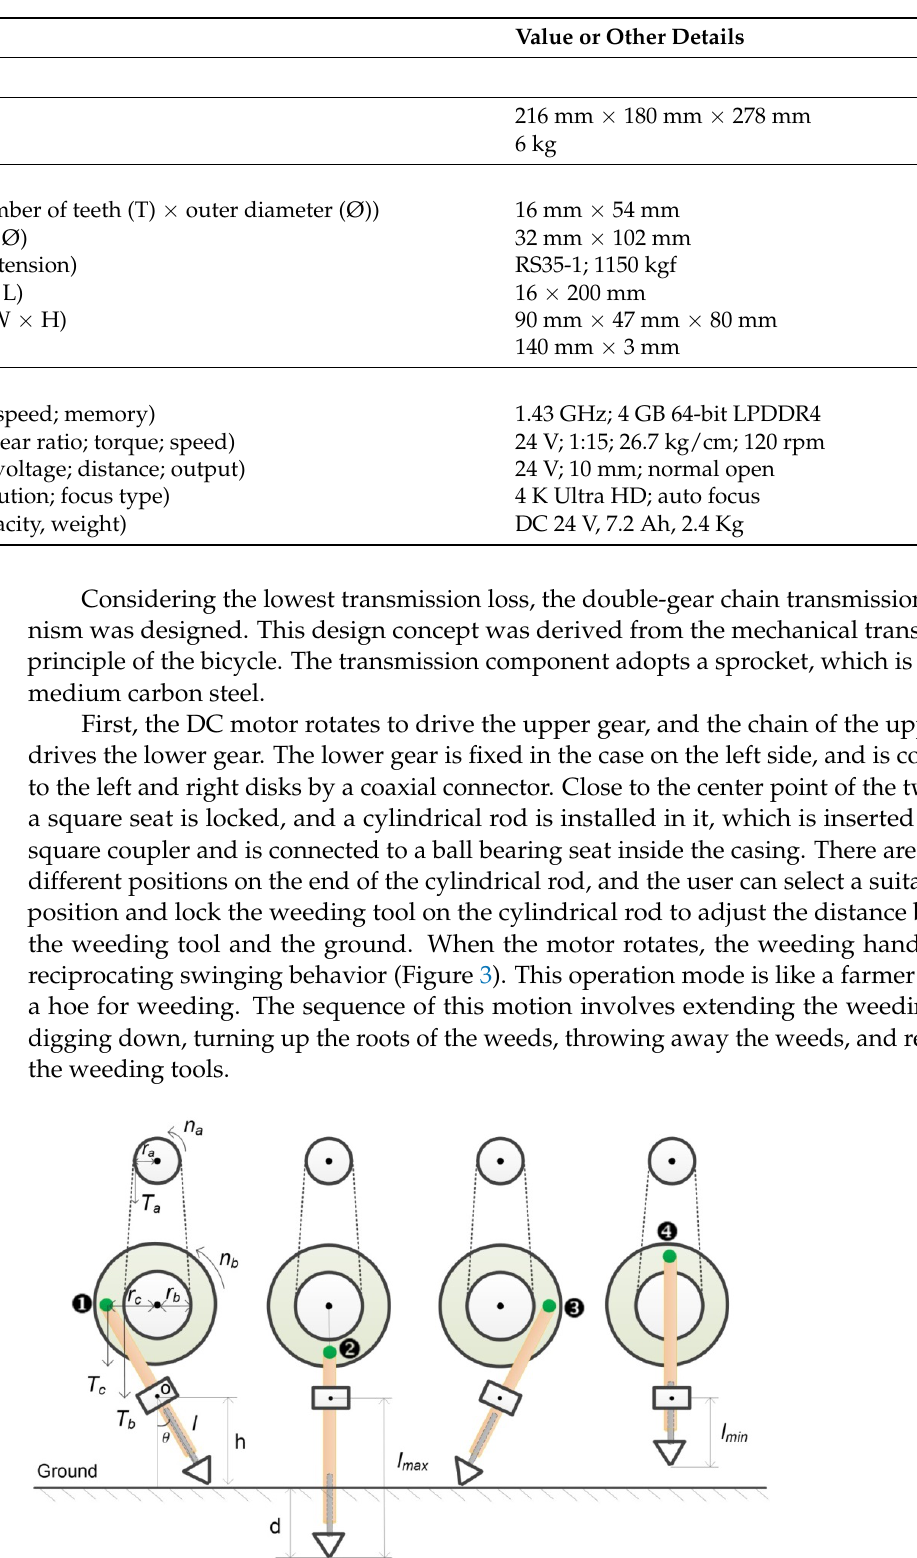
Table 1. The specifications of the weeding machine.